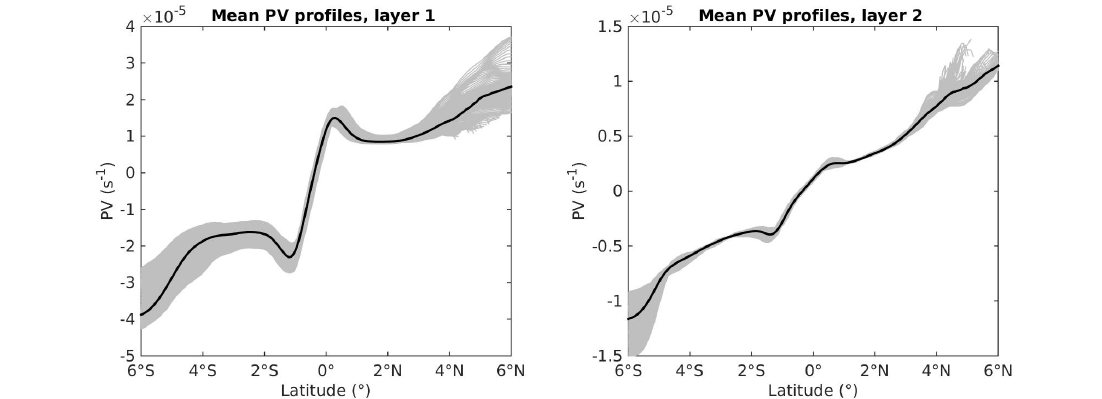
Figure 6. Latitudinal PV profiles over the longitude band [20 ◦ W, 0 ◦ E] for each layer (in gray). The average profile over this longitude range is the thick black